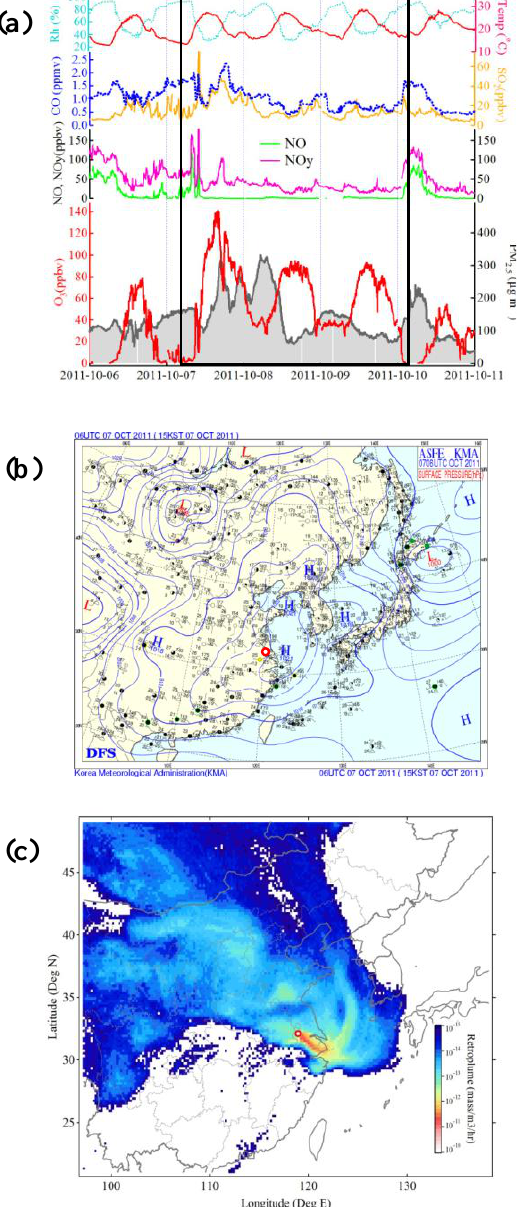
Figure 7. ( a ) Time series of O Fig. 7. (a) Time series of O 3 , PM 2 . 5 , related trace gases and me- teorological parameters for Case I, i.e., 6–10 October, 2011. (b) Case I , i.e. 6-10 October, 2011. ( b ) Weather chart on 7 October 2011. ( c ) Averaged 3 Weather chart on 7 October 2011. (c) Averaged retroplume of air masses at Nanjing for the period indicated at bottom of (a) . Note: retroplume of air masses at Nanjing for the period shown as back box shown in 7( a ). Note: 4 The red circle in (b) and (c) shows SORPES site location. The red cicle on the map shows the site location. 5